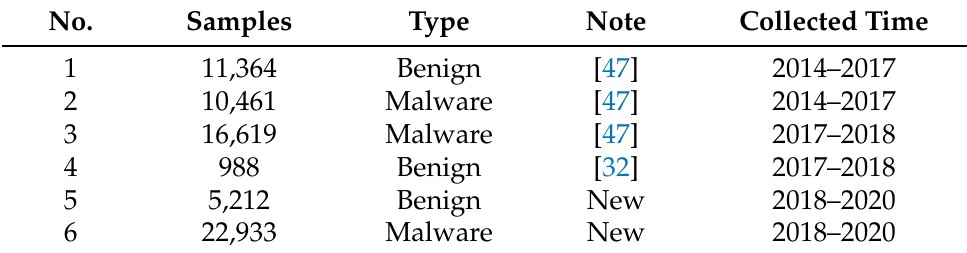
Table 7. Collected Android program